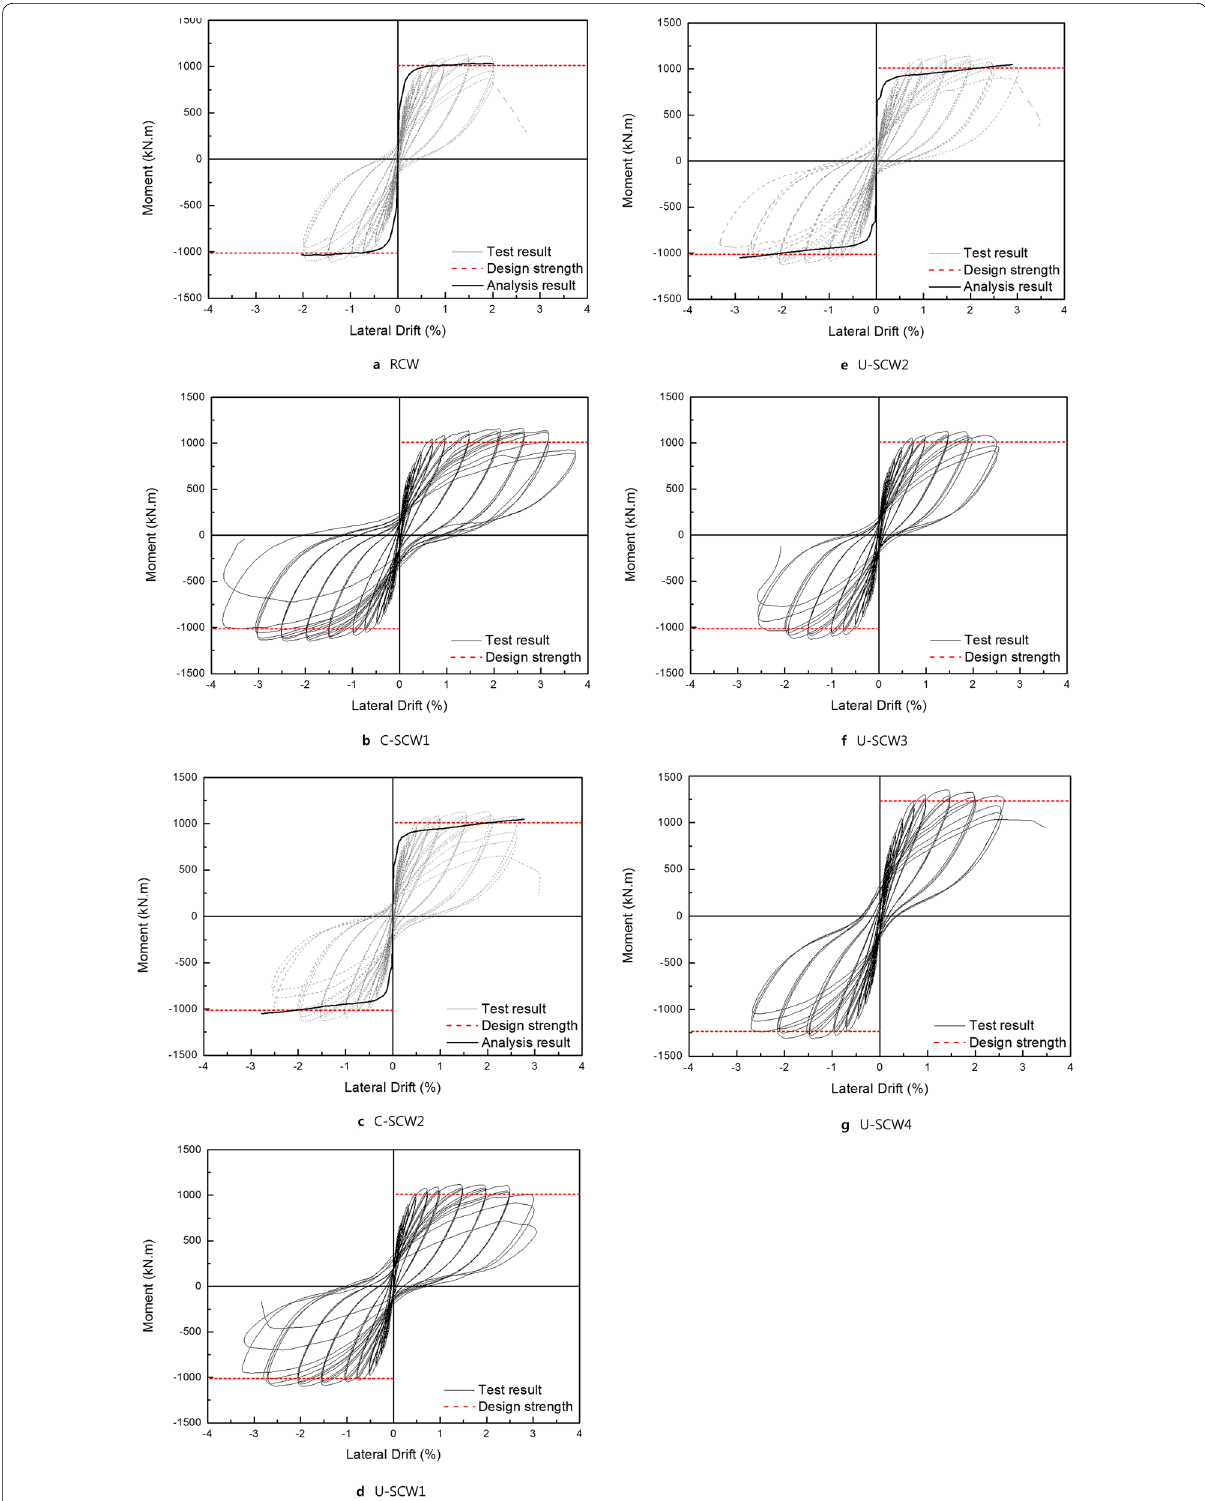
Fig. 12 Moment versus lateral drift loops for